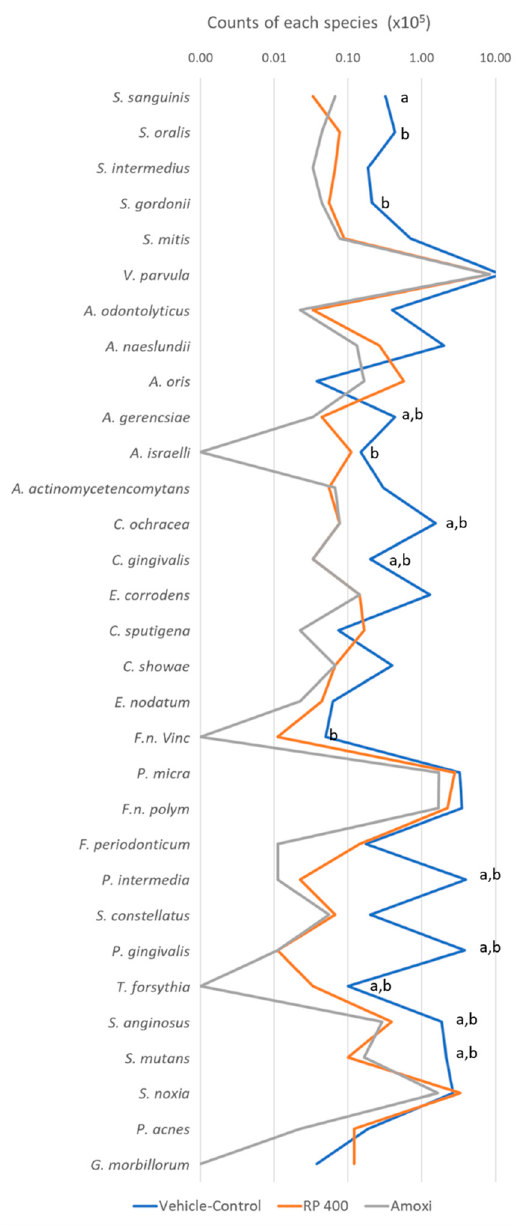
Figure 4. Mean total counts of bacterial strains in biofilms treated with the vehicle control, BRP extract (400 µg/mL) and amoxicillin (AMOXI) (54 µg/mL). The data were analyzed by Kruskal–Wallis followed by Dunn’s post-hoc test ( p < 0.05). Letter “a” indicates statistically significant differences between BRP (400 µg/mL) and the vehicle-control but no difference between BRP (400 µg/mL) and AMOXI; letter “b” indicates statistically significant differences between AMOXI and the vehicle-control but no difference between AMOXI and BRP (400 µg/mL).